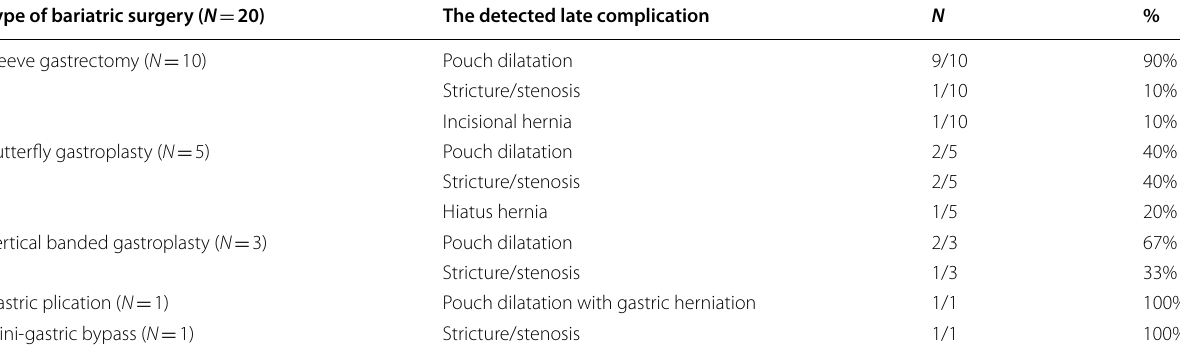
Table 1 Frequency of late post‑operative complications in studied patients in relation to different bariatric surgeries performed Type of bariatric surgery ( N 20) =